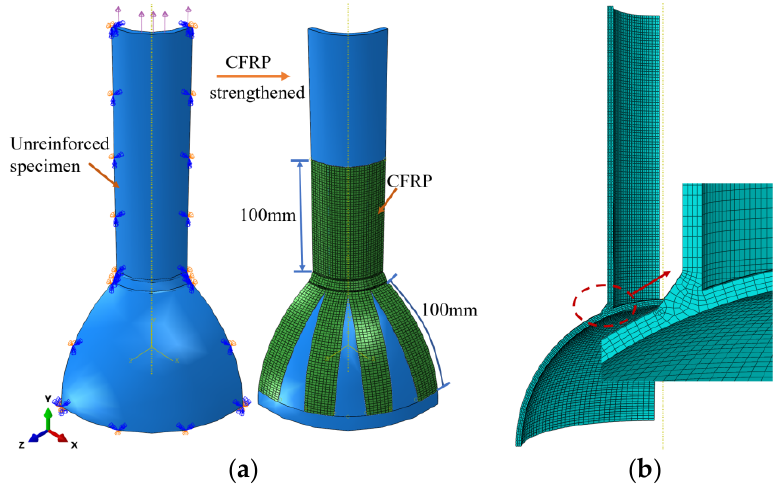
Figure 3. FE modeling process. ( a ) Finite element model; ( b ) Mesh division.